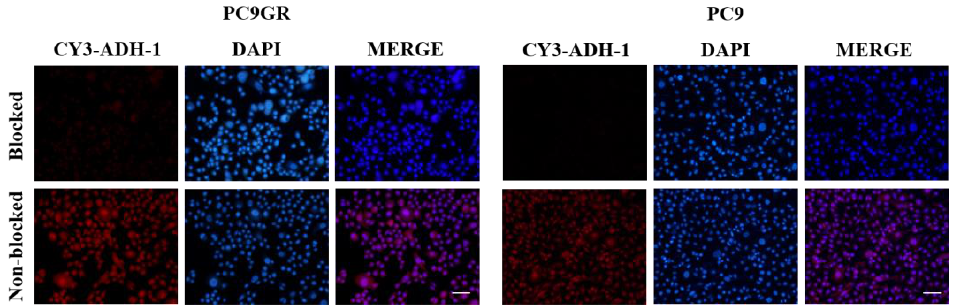
Figure 5. Effect of excessive ADH-1 on uptake of Cy3-ADH-1 in PC9GR and PC9 cells through a fluorescence microscope (100×). The cells of the blocked group had 1mM unlabeled ADH-1 added 30 min in advance. Scale bar, 100 μ m.